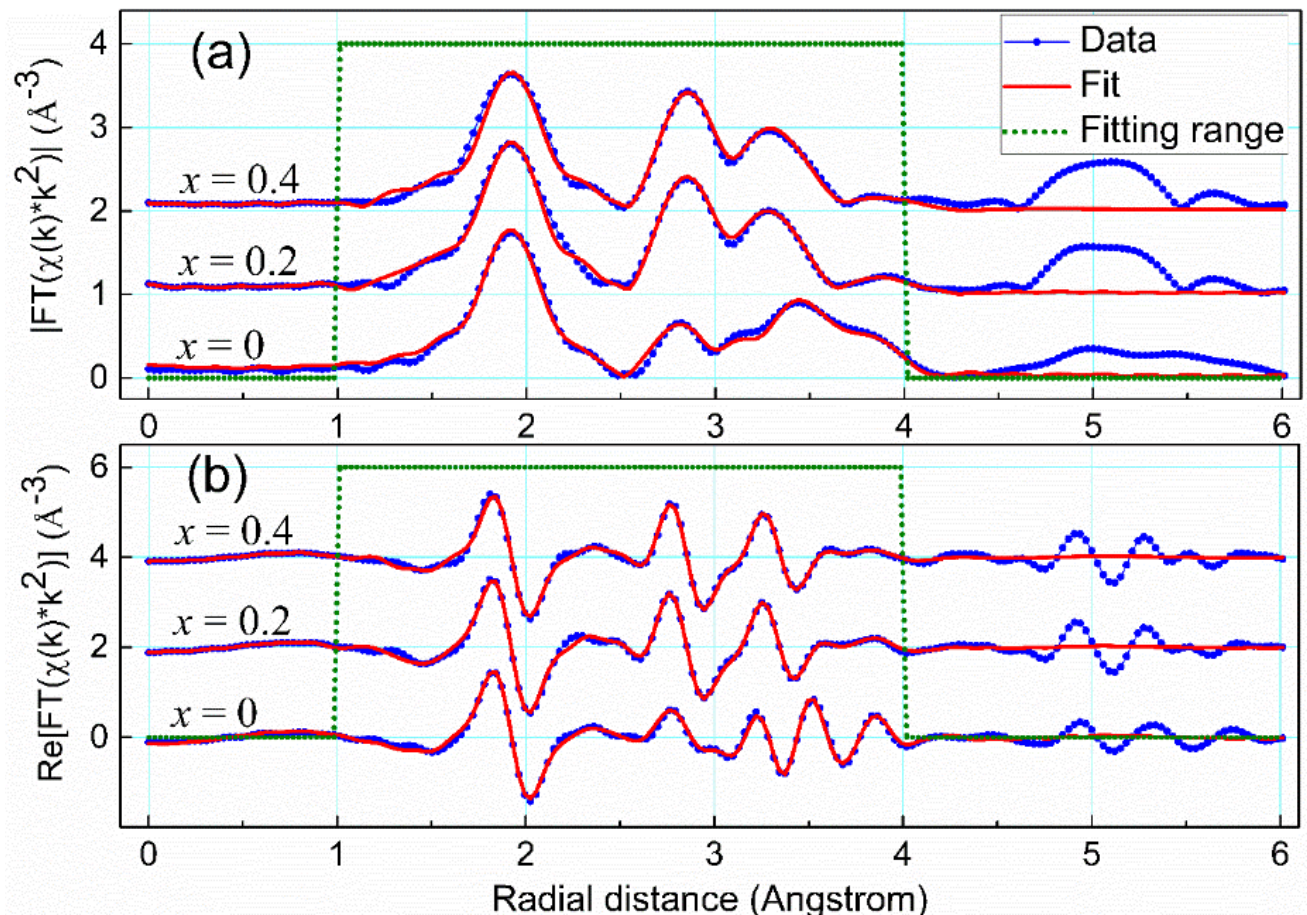
Figure 11. Data and fit for EXAFS data of La 1 − x Ce x CoO 3 with x = 0, 0.2, and 0.4: ( a ) magnitude and ( b ) real part of Fourier transform from the corresponding k 2 -weighted χ ( k )